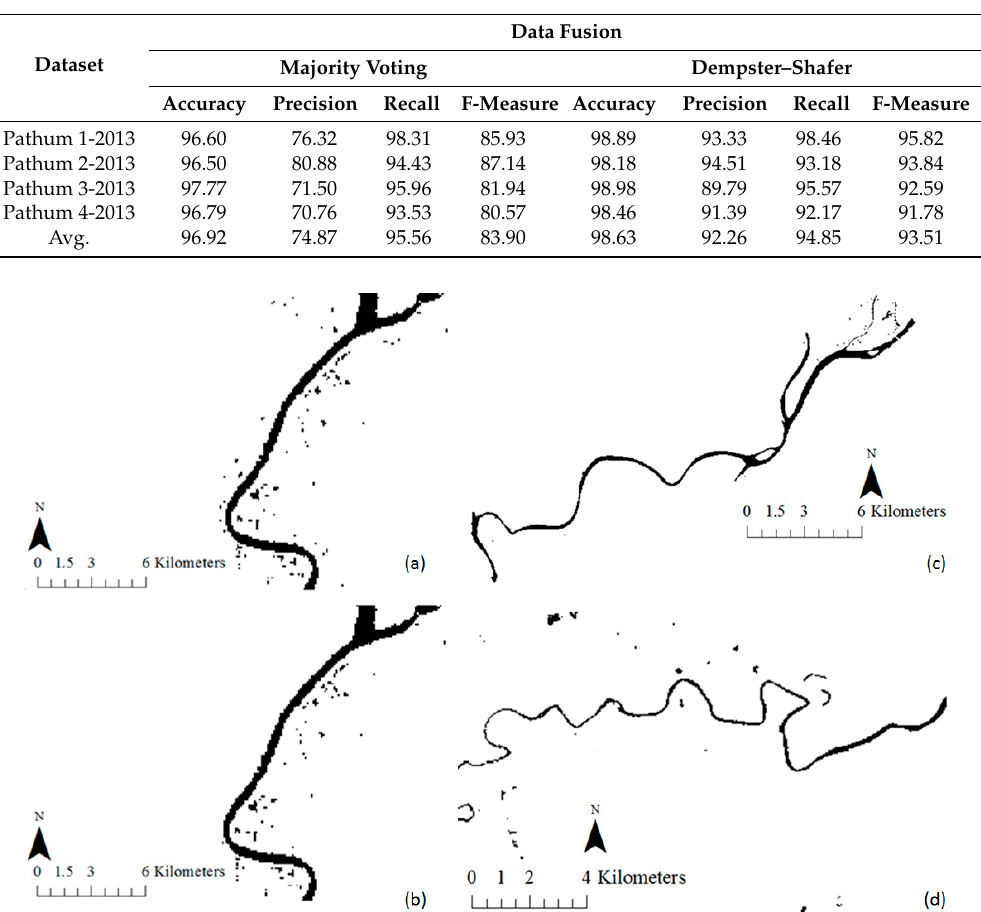
Table 4. Numerical assessment of Landsat with DSM fusion with two-variable (water indices) MMI optimized thresholding.